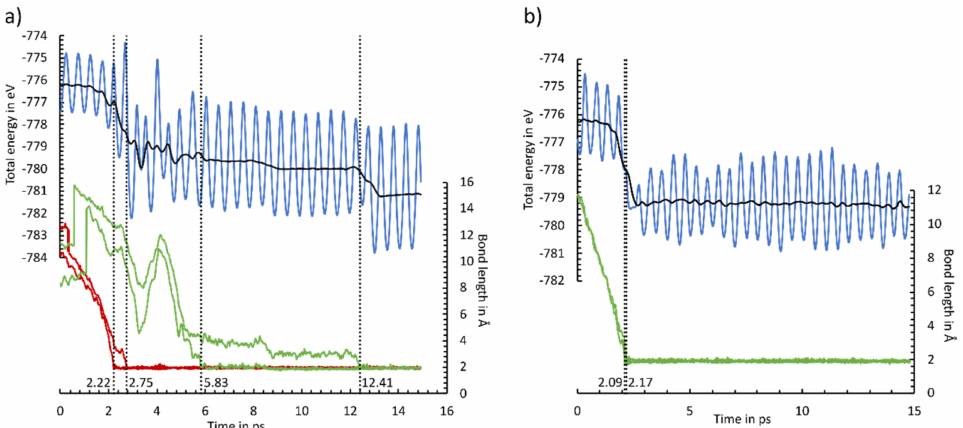
Figure 9. Energy (blue line) and C-Si bond length (green line: cyclooctyne group; red line: ethinyl group) changes for MD simulations 1 ( a ) and 4 ( b ). The two-sided moving average of the energy is shown as a black line. Dotted lines indicate the C-Si bond formation, stated with the time